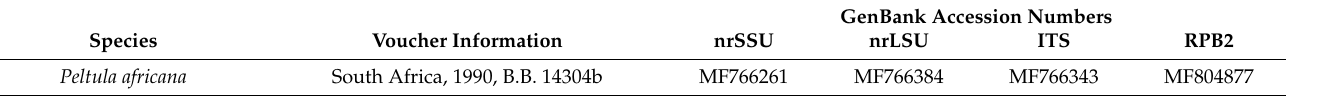
Table 1. Specimens used for DNA extraction and GenBank accession numbers of all samples used in this study. Regarding the voucher information, B.B. refers to B. Büdel, Kaiserslautern, Germany; M.S. to M. Schultz, Hamburg, Germany; K.K. to K. Kalb, Neumarkt, Germany; DUKE refers to Duke University. Newly generated sequences are in